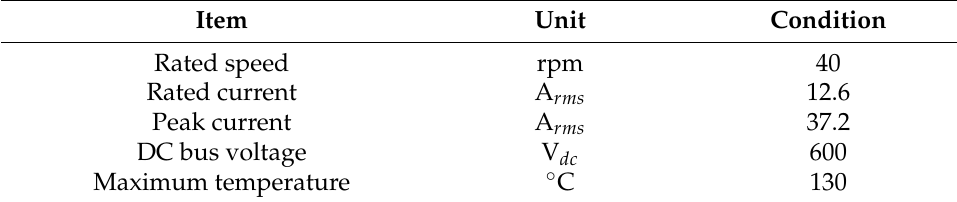
Table 3. Operating condition.